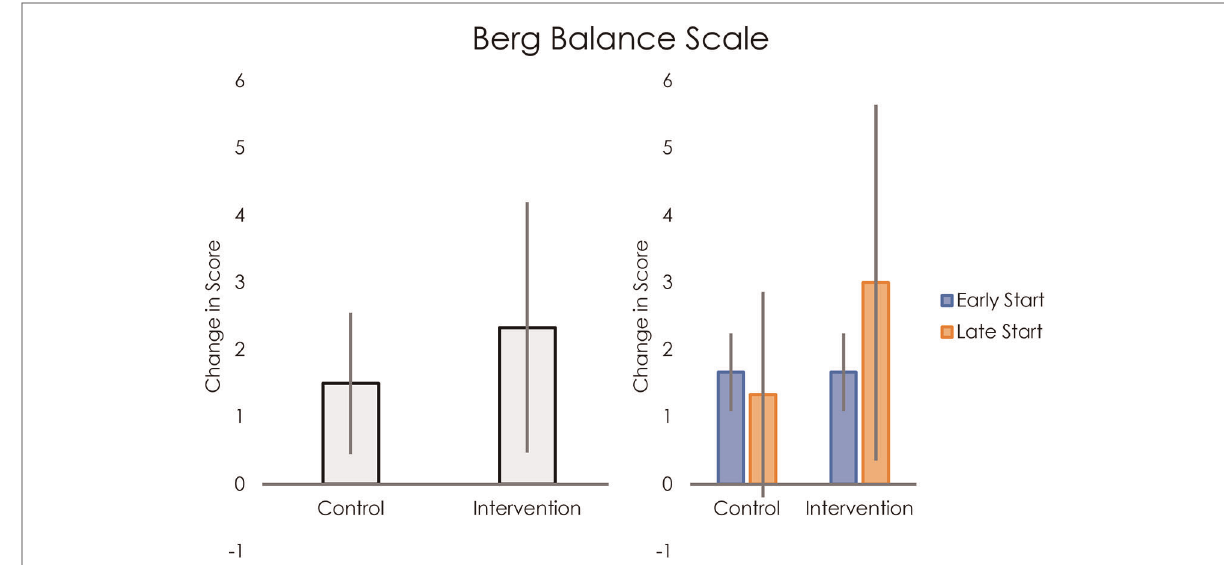
FIGURE 4 Left: average change in Berg Balance Scale scores for control and intervention groups. Right: Average change in Berg Balance Scale scores for control and intervention groups, separated into early and late intervention start.